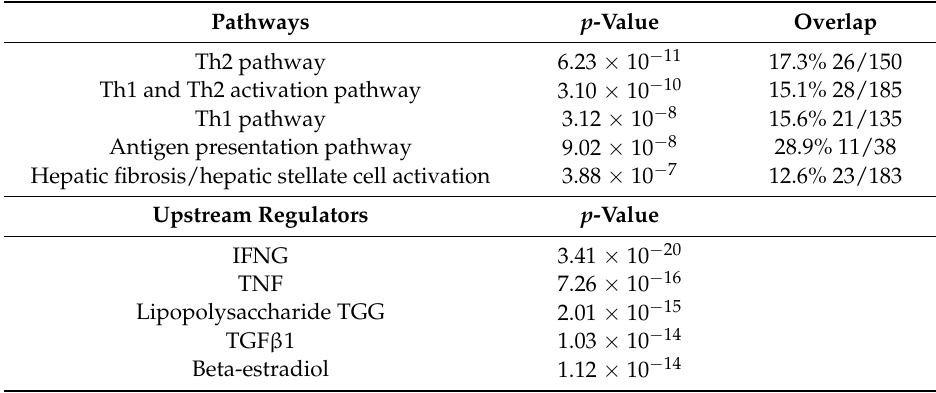
Table 4. Top affected pathways and upstream regulators. TGF β 1: Transforming growth factor beta 1, TNF: tumor necrosis factor, IFNG: Interferon